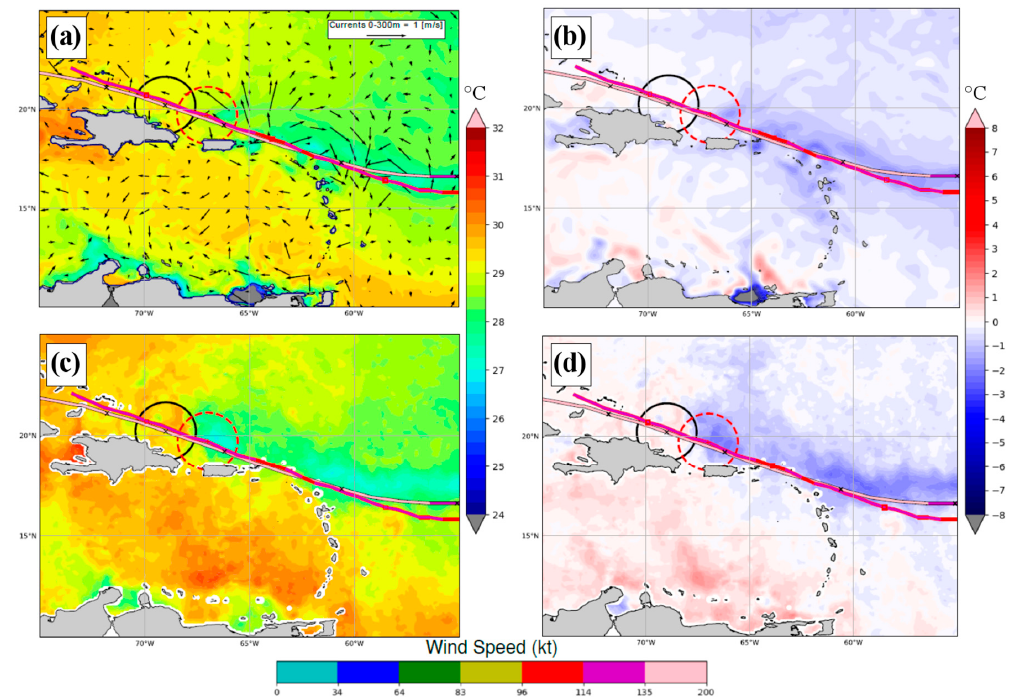
Figure 10. As in Figure 7, except for the case study of Irma (AL112017), initialization time of 1200 UTC 03 September 2017. Fields shown are as of forecast lead time of 96 h (1200 UTC 07 September 2017): SST ( a , c ) and SST change ( b , d ) for ( a , b ) MPIPOM-TC model output and ( c , d ) MWIR satellite SST.